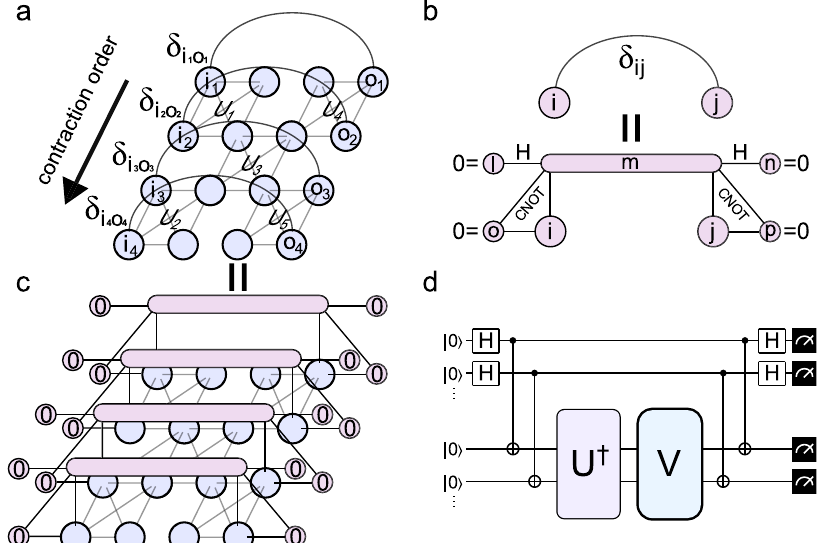
Fig. 3 Pictorial depiction of the trace evaluation algorithm. a Graphical tensor network of the trace of a quantum circuit, black where nodes are tensor indices, and cliques are tensors. The i indices correspond to qubit inputs, and the o indices correspond to qubit outputs. The curves going above the circuit network are identities. The input and output indices can actually be merged together, but this is harder to illustrate. b Equivalent identity tensor that can be represented by gates, qubit initialization, and measurement. More details at the end of section 2.1. c Graphical tensor network representation of the same quantity using our formulation. d The quantum circuit used to evaluate traces as a single